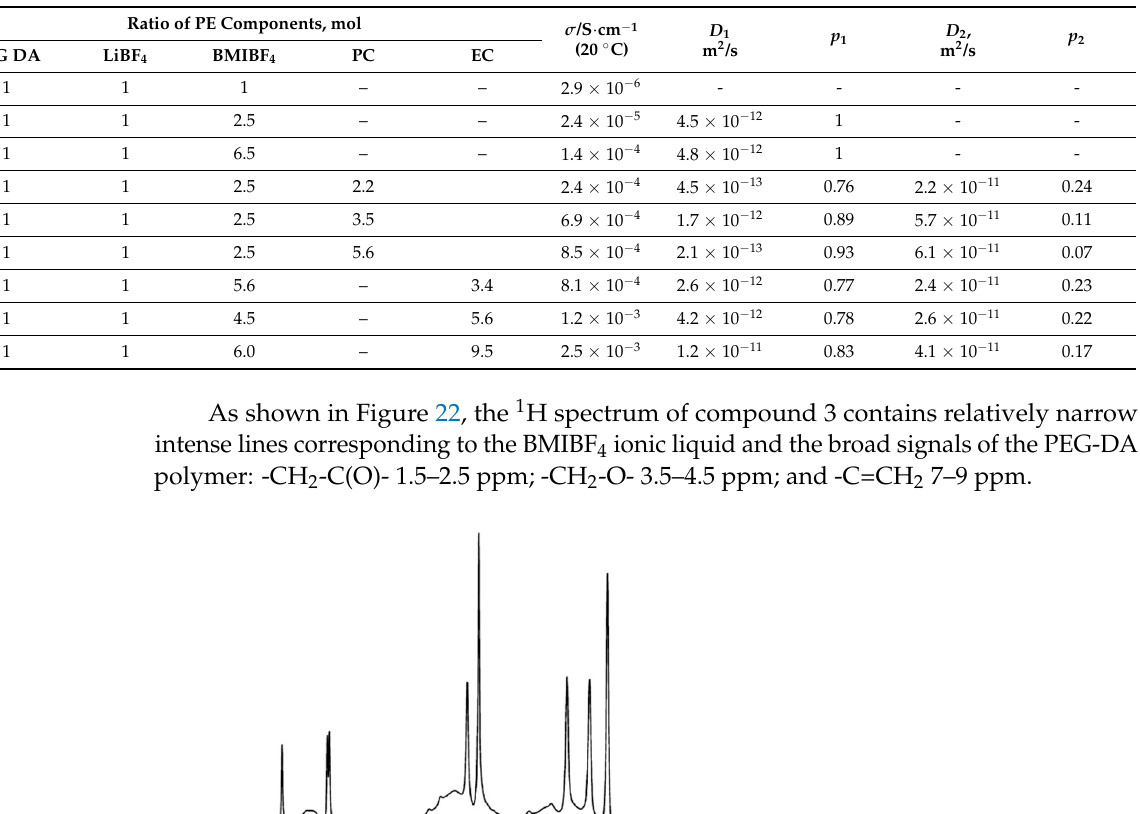
Table 6. Composition, conductivity ( σ ), and self-diffusion coefficients ( D s ) of PE measured by the PFG 7 Li NMR technique.